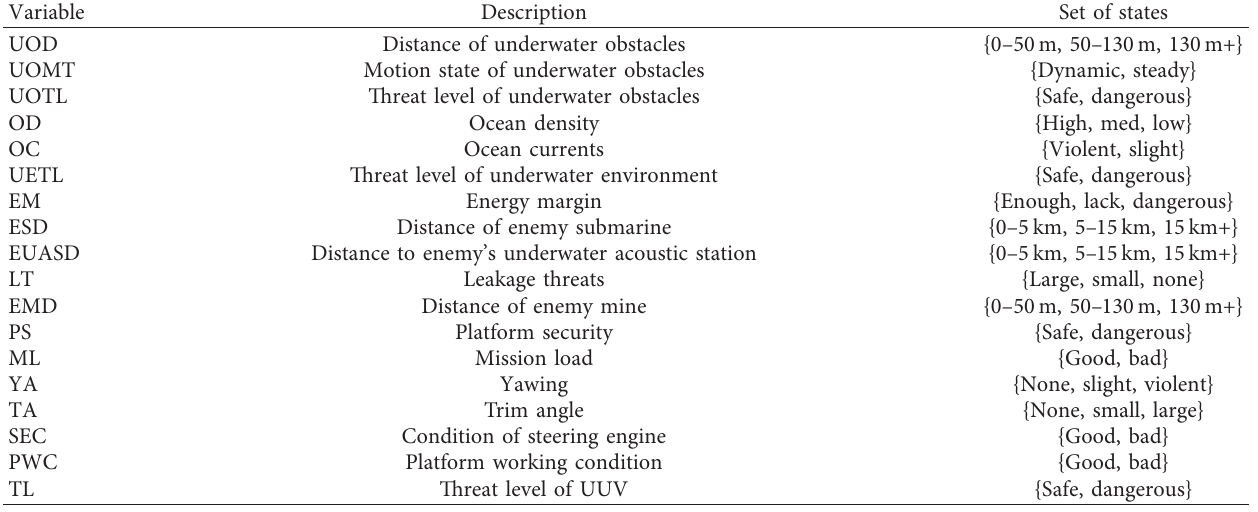
Table 1: State set of UUV threat assessment model nodes.